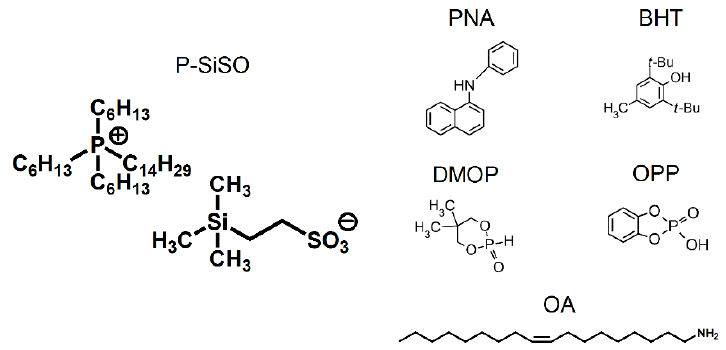
Figure 1. Chemical structures of evaluated ionic liquid base fluid and additives.